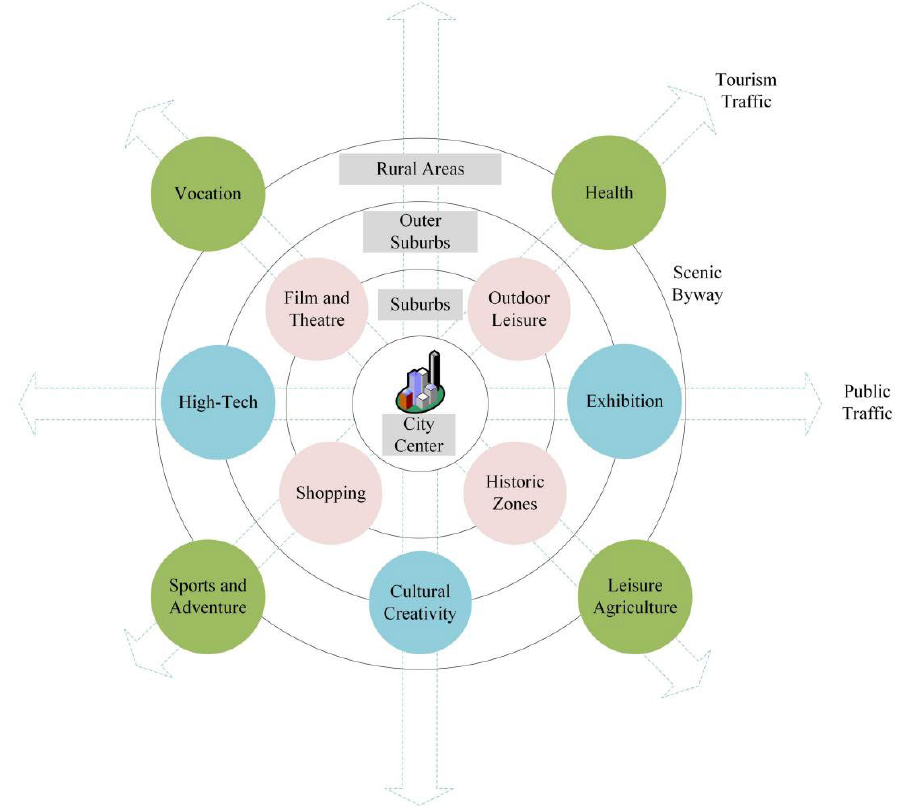
Figure 3. Network of urban tourist destinations.